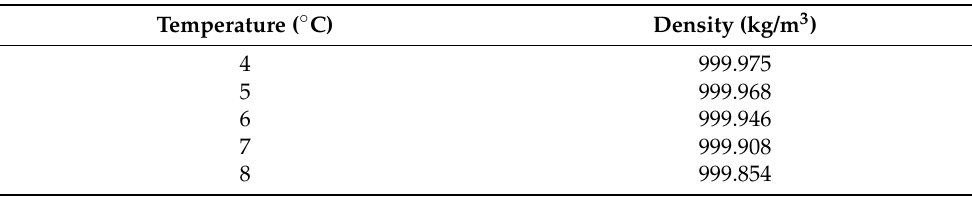
Table 3. Water density vs.